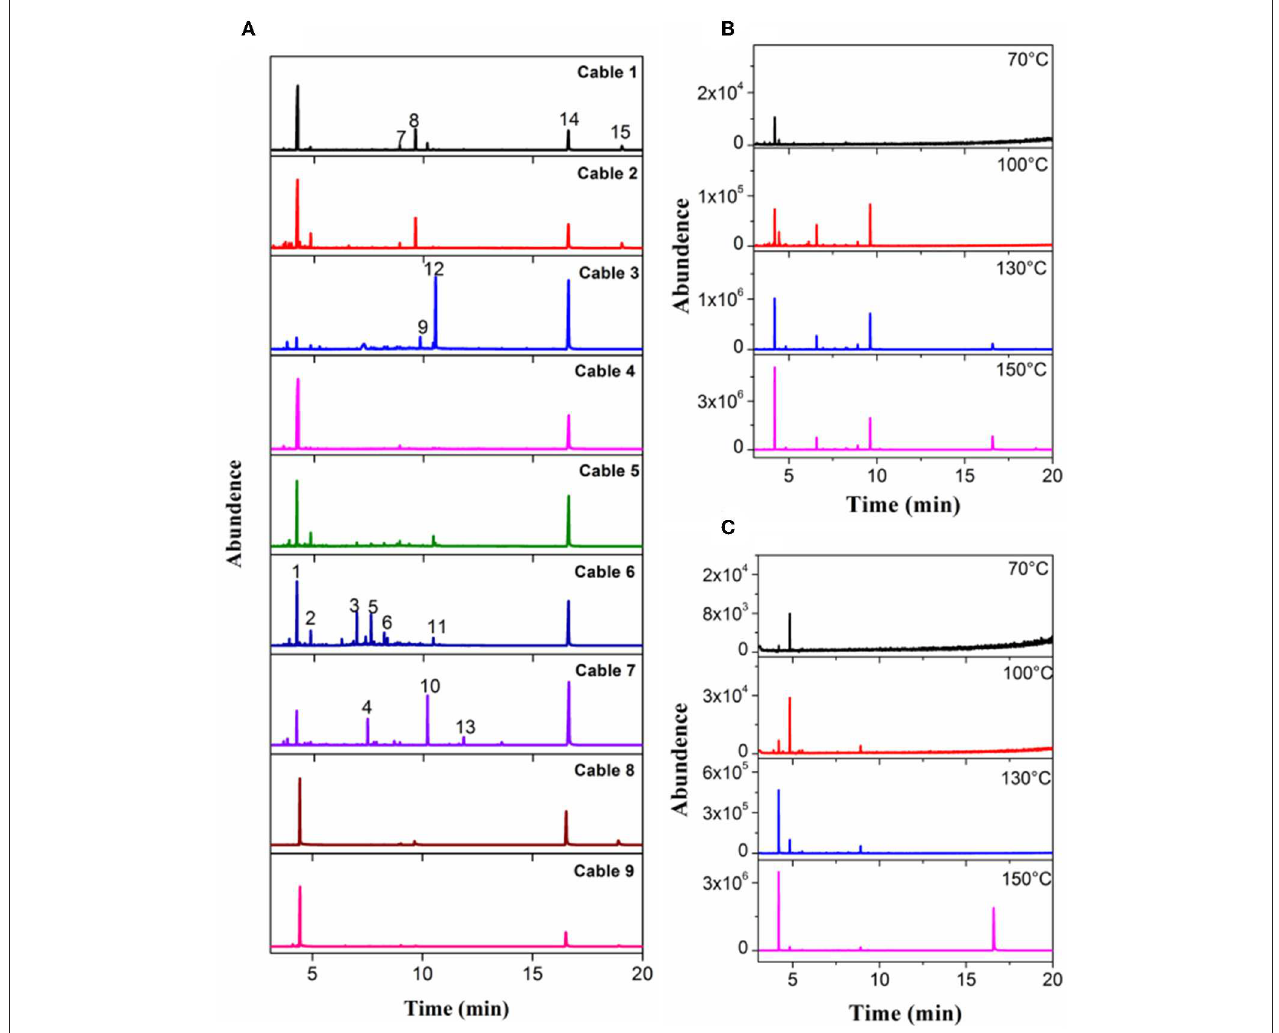
FIGURE 2 | Chromatograms measured with headspace GC-MS for (A) Cable 1–9 at 200 ◦ C, (B) Cable 1, and (C) Cable 4 at selected